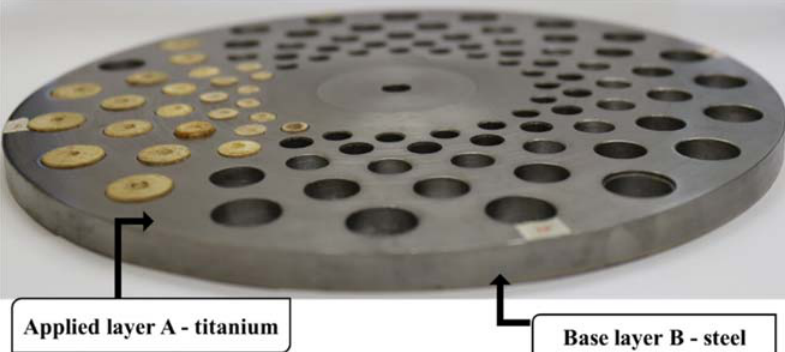
Figure 2: Model of bimetallic perforated plate.